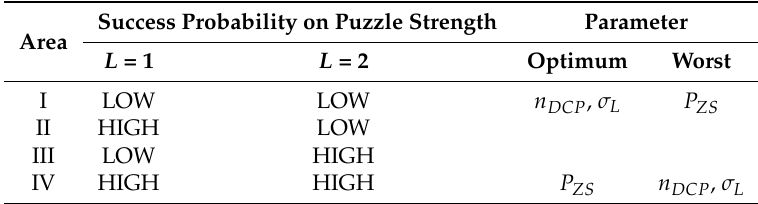
Figure 7. Standard deviation in DCP for L max = 2. Table 3. Success Probability Summary for Optimum Threshold Function